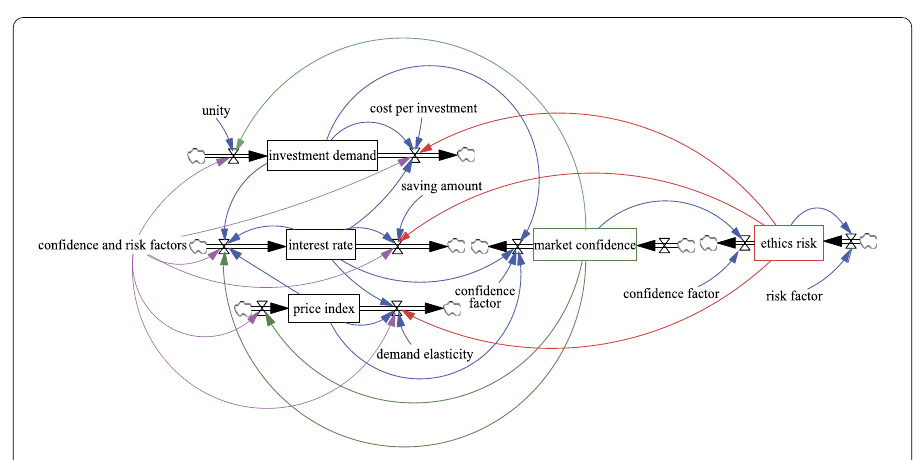
Figure 3 A schematic diagram of financial system (3) with market confidence and ethics risk